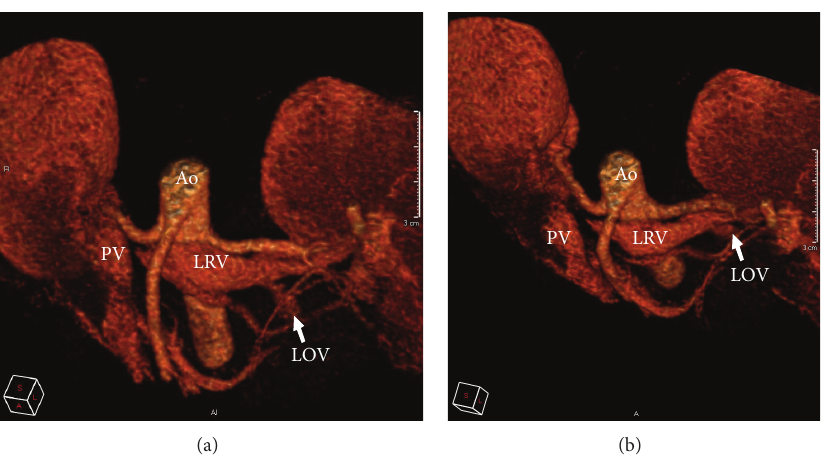
Figure 2: (a) and (b) 3D reconstructions of a nutcracker phenomenon. The left renal vein is compressed as it approaches the right renal artery and portal vein. Ao: aorta; PV: portal vein; LRV: left renal vein; LOV: left ovarian